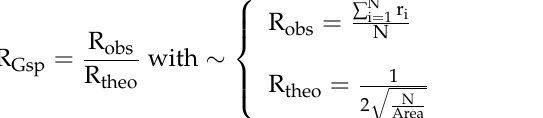
where N represents the number of trees for a given Gsp and r i is the distance between tree i and its closest neighbour of the same